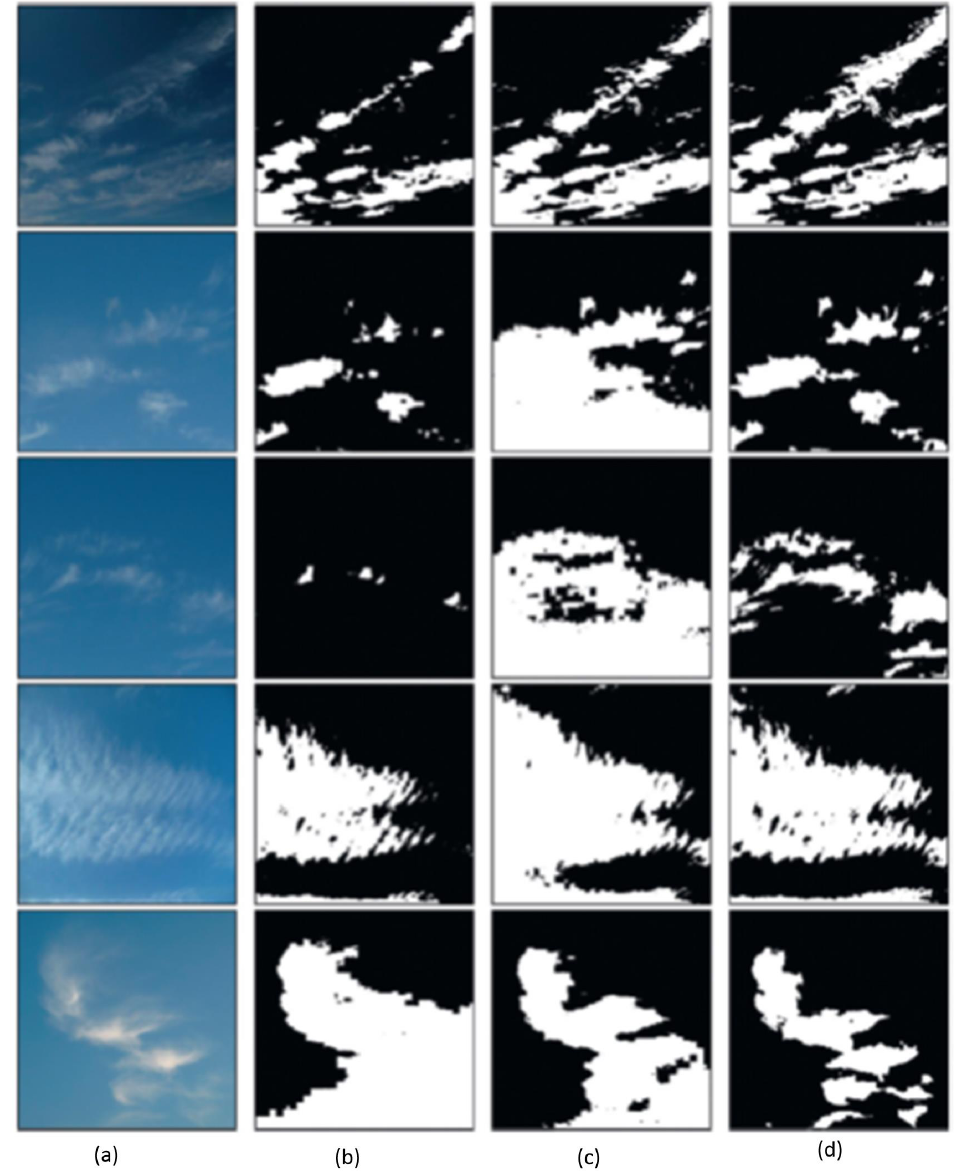
Figure 3. ( a ) Original Image, cloud detection results using ( b ) fixed threshold ( c ) adaptive threshold and ( d ) BSAT in [27]. © American Meteorological Society. Used with